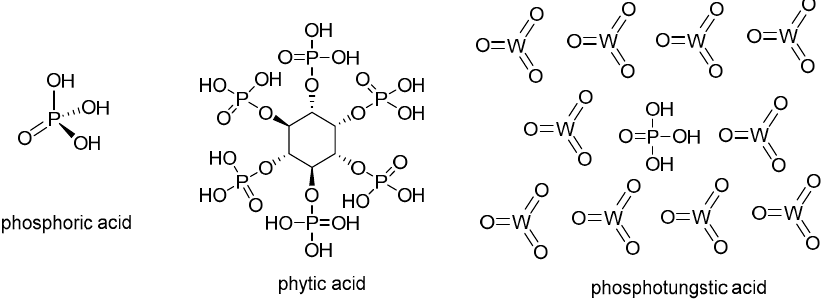
Figure 4. Chemical structures of phosphoric acid, phytic acid, and phosphotungstic acid.